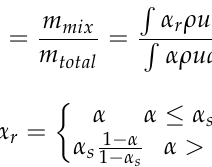
Case6, Case4, and Case8 increase by 9.0%, 26.7%, and 56.7%, respectively, compared with Case2. The angle of SWG is between 10 and 30°, and the mixing efficiency increases with the angle increase.